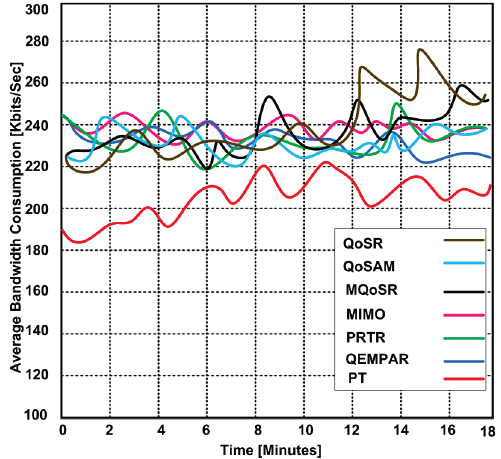
Figure 10. Bandwidth consumption at different time